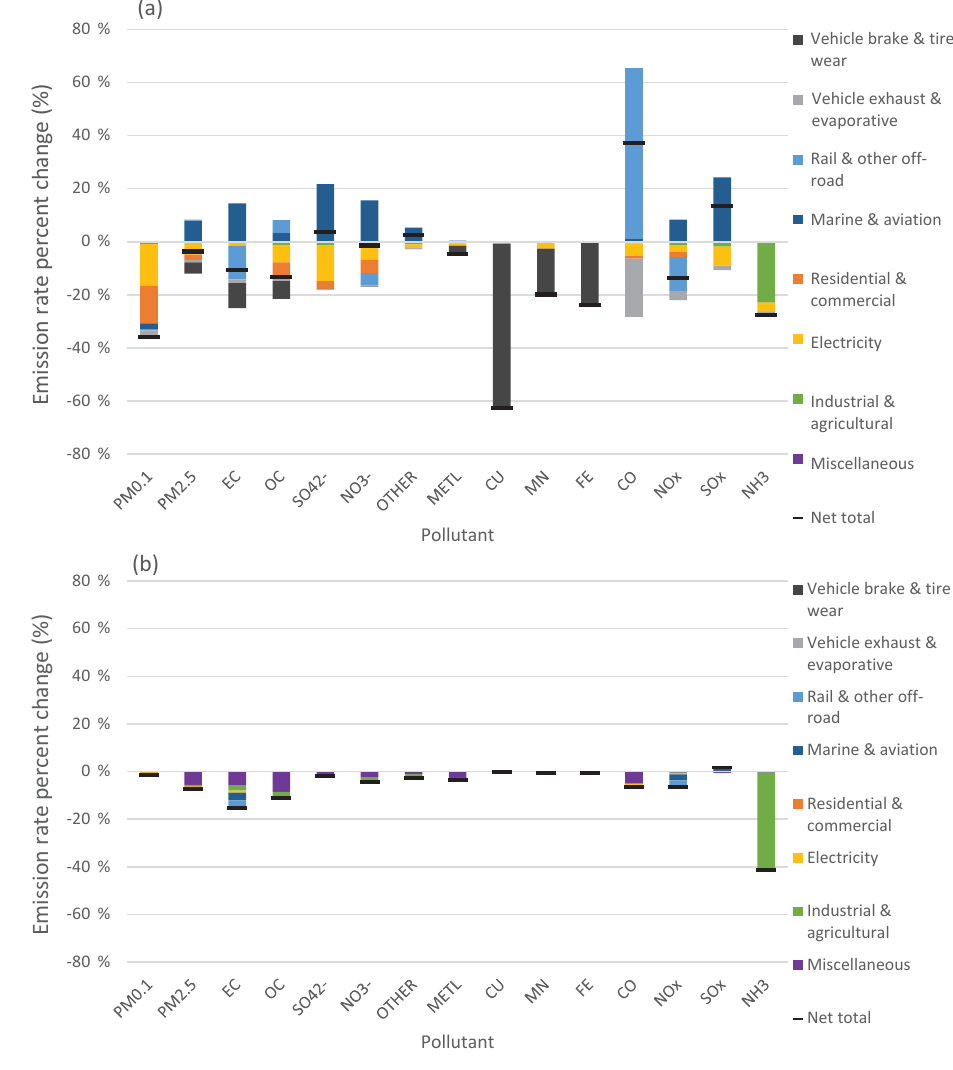
Figure 18. Change in pollutant emissions rate relative to BAU scenario. Panel (a) represents GHG-Step analyzed in the current study using the CA-TIMES model. Panel (b) represents expert analysis presented by Shindell et al.